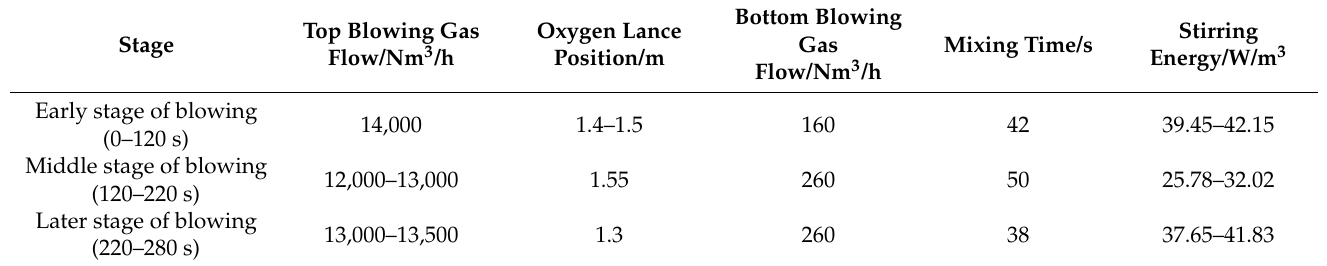
Table 6. Stirring energy calculated and mixing time of molten bath measured at each stage of